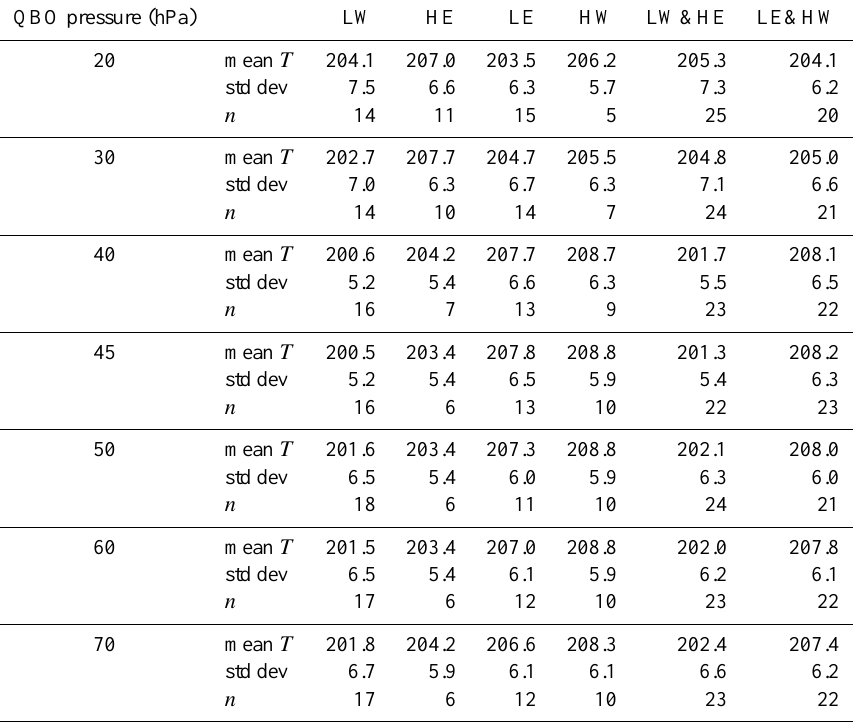
Table 2. Mean JF temperature of the polar stratosphere at 30hPa sorted by low/high solar activity (defined by values of F10.7 of < / > 155 units) and QBO phase determined by the sign of the zonal wind over the equator at the given pressure levels. Also given in each segment are the standard deviation of the temperature data and number of data